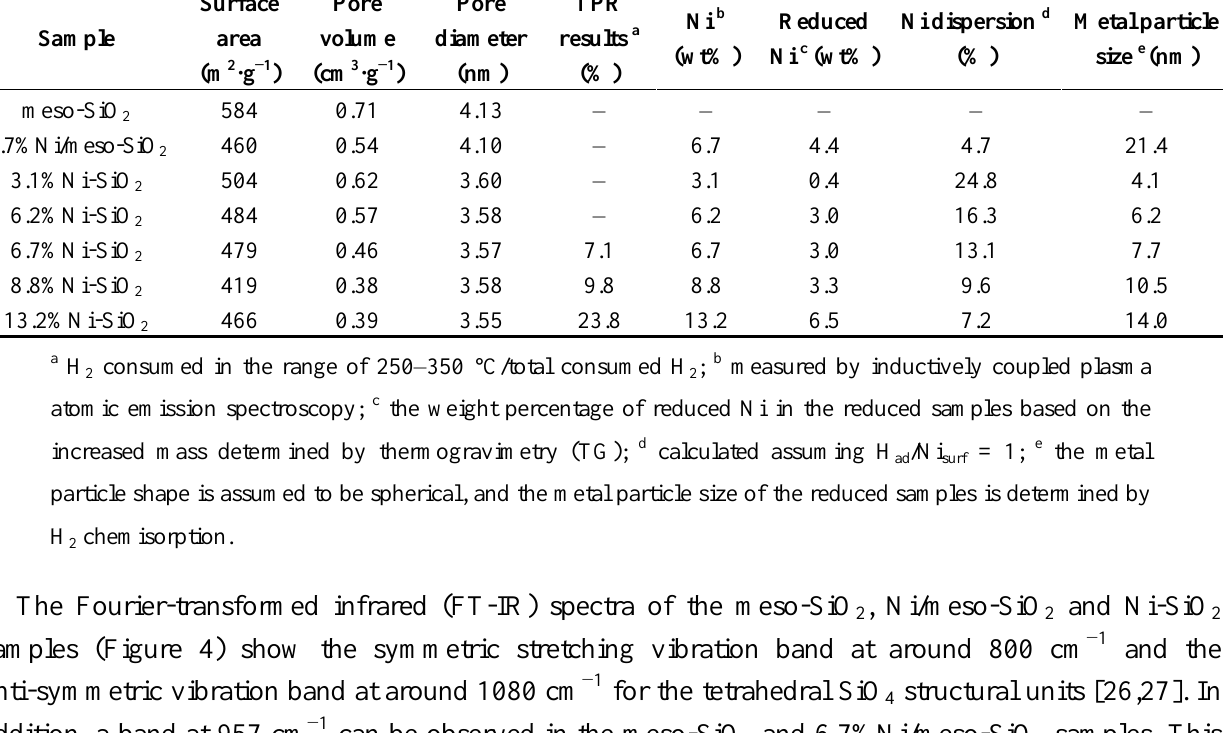
, Ni/meso-SiO and Ni-SiO samples. 2 2 2